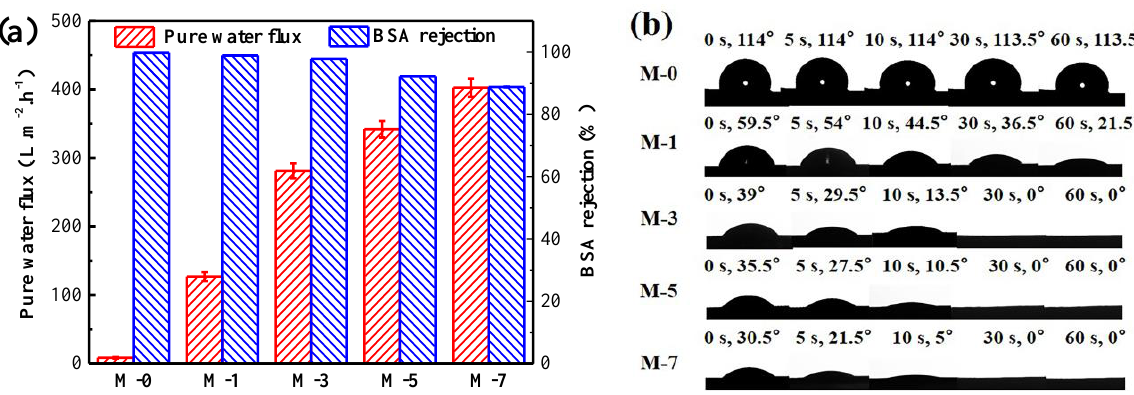
Figure 5. Pure water flux and BSA rejection ( a ) and water contact angle ( b ) of membranes. The variation of the underwater oil contact angle (UOCA) for various membrane surfaces is illustrated in Figure 6a. It was found that the UOCA of M-0 was about 82.0°, which indicated the inherent oleophilicity of M-0. However, the UOCA gradually increased when the F127@SMA was added. More specifically, the UOCA of M-1 increased to 137.0°, and the UOCA of M-3, M-5, and M-7 were 160.0°, 157.0°, and 158.5°, respectively. In addition, different oils were selected to perform UOCA tests on the M-0 and M-3. As depicted in Figure 6b, the M-0 membrane displayed conspicuous under oleophilicity. The UOCAs of the M-0 surface against petroleum ether, toluene, dichloroethane, kerosene, and crude oil were 81.0°, 78.5°, 80.5°, 87.5°, and 83.0°, respectively. However, the UOCA of M-3 increased towards 155.5°, 150.5°, 151.5°, 163.5°, and 161.0°, which confirmed the underwater superoleophobicity for M-3. From these results, it was demonstrated that by adding the F127@SMA polymer, the membrane surface could be converted from extremely lipophilic to underwater superoleophobic.